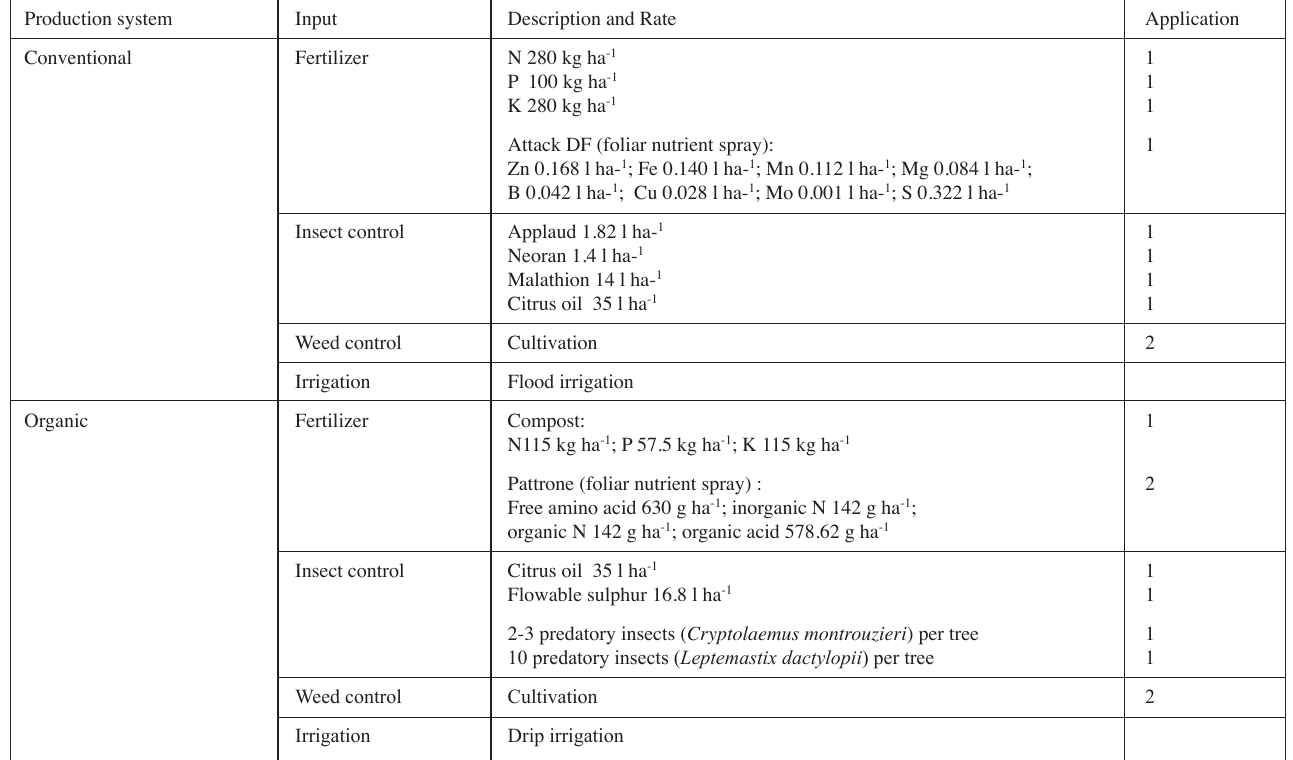
Tab. 1: Fertilizer, weed and insect control inputs of conventionally and organically grown Washington Navel orange orchards Production